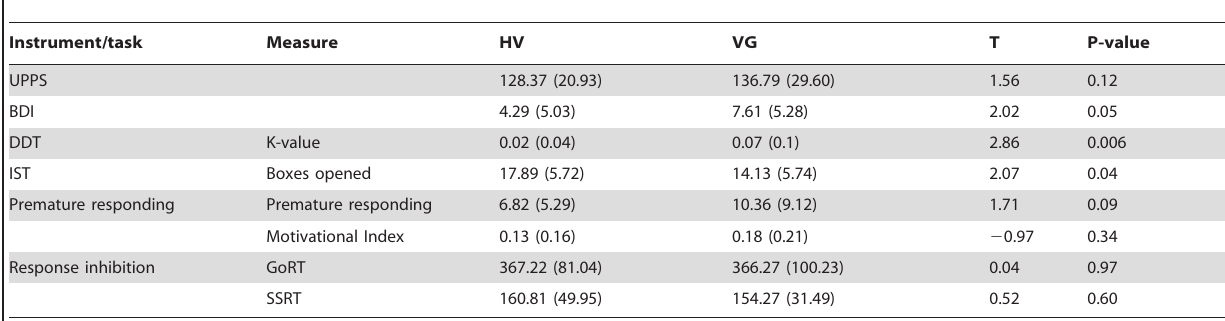
Table 2. Outcome measures (data are mean + / 2 S.D).